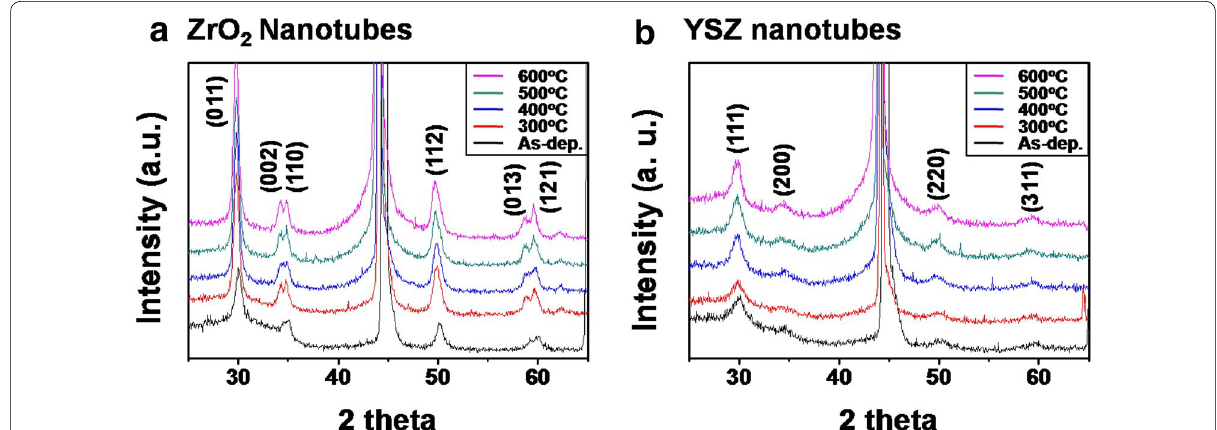
Fig. 2 XRD patterns with and without yttira doping at various annealing conditions. a ZrO 2 NTs exhibited tetragonal phase (JCPDS #50-1089), and b YSZ NTs, cubic phase (JCPDS #30-1468)